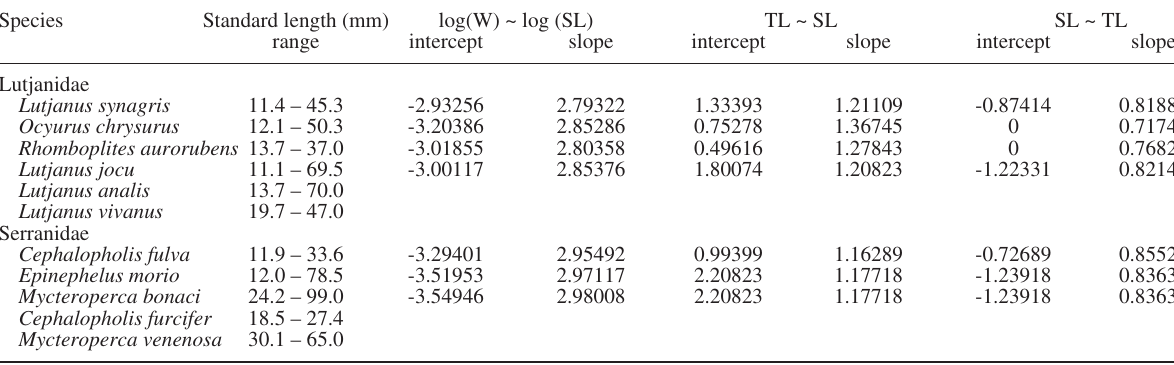
Table 3. – Size range, Standart Length-Weight (SL-W) and Total Length - Standard Length (TL-SL) relationships for the eleven most com- mon lutjanids and serranids studied in the Abrolhos Bank, Brazil. Species